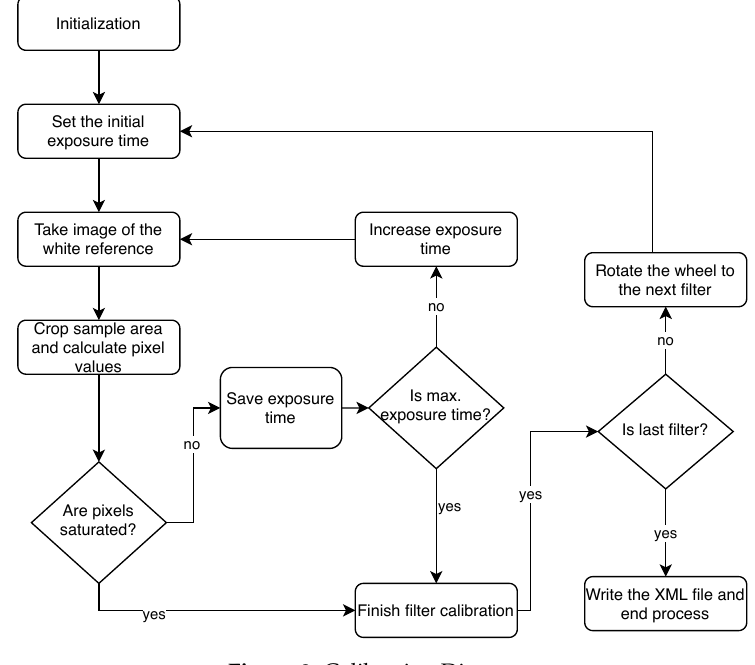
Figure 8. Calibration